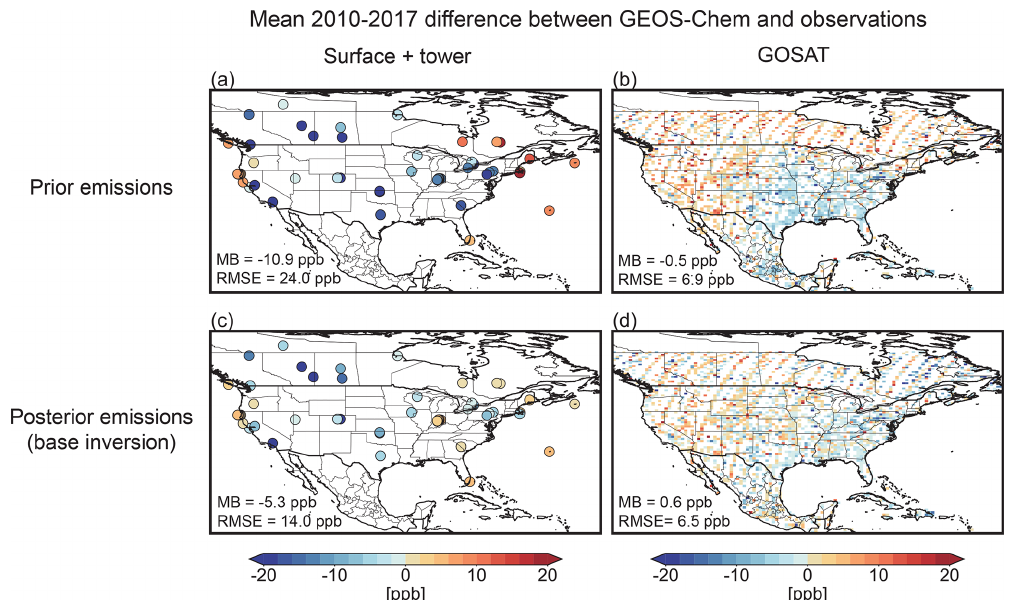
Figure 5. Ability of the base inversion to fit the in situ (surface and tower) and GOSAT observations for 2010–2017. The figure shows the mean differences between GEOS-Chem simulations and the observations using either prior or posterior methane emissions. Mean bias (MB) and root mean square error (RMSE) are shown in the inset, calculated from the temporally averaged differences for each in situ site or GOSAT grid